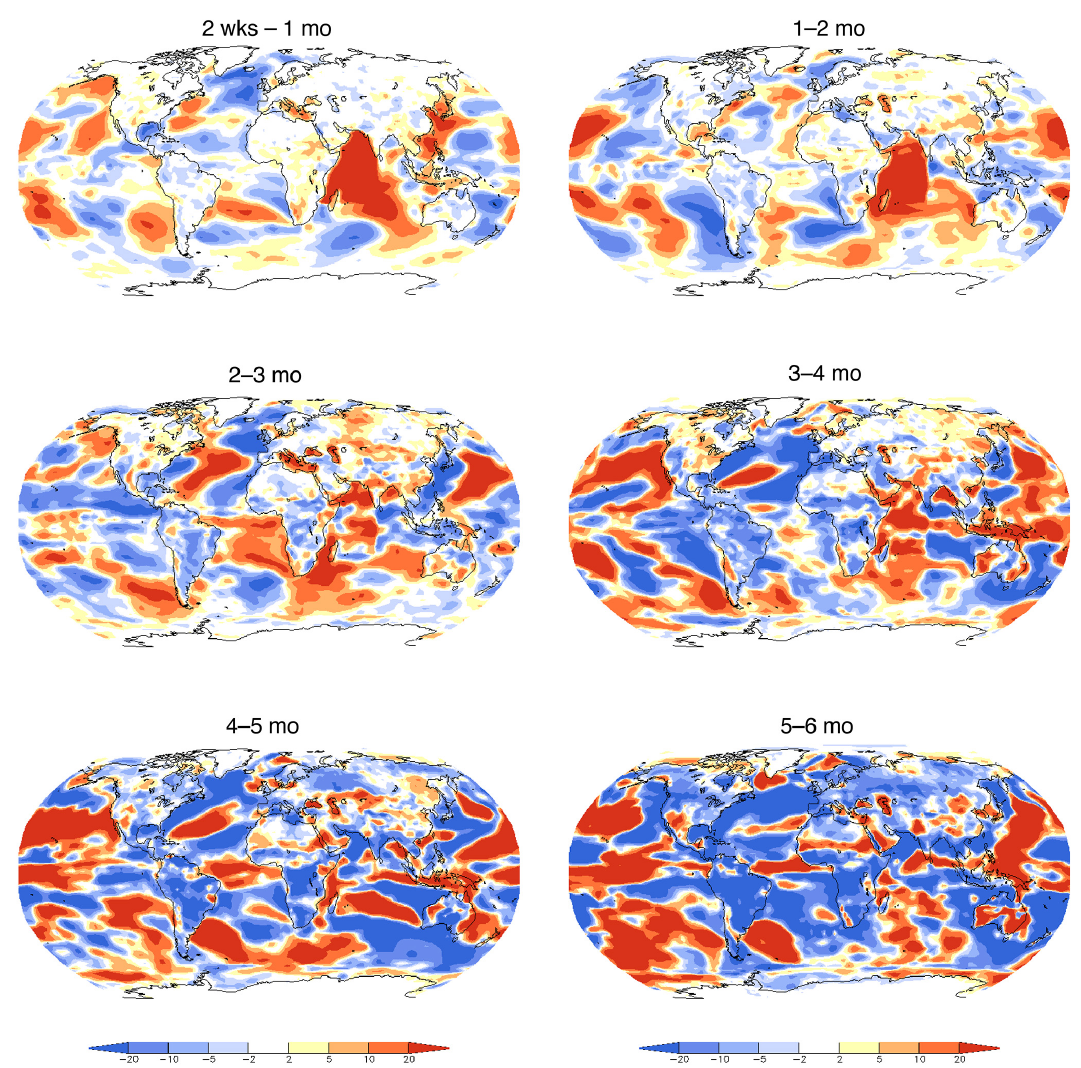
Figure 7. As in Fig. 6 but for the sensitivity of latent heat flux changes to a 1K temperature perturbation to the northwest Indian